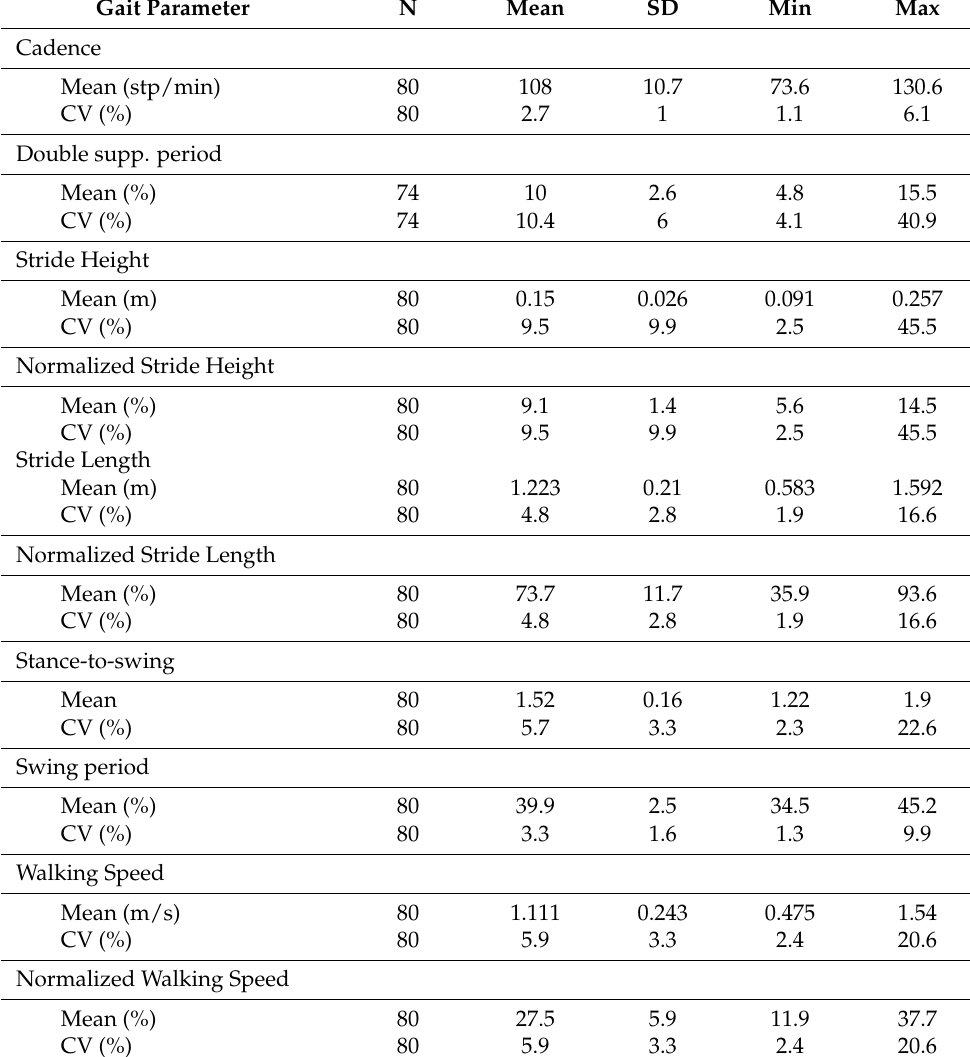
Table 2. Mean and coefficient of variation (CV) for temporal and spatial gait parameters. Gait